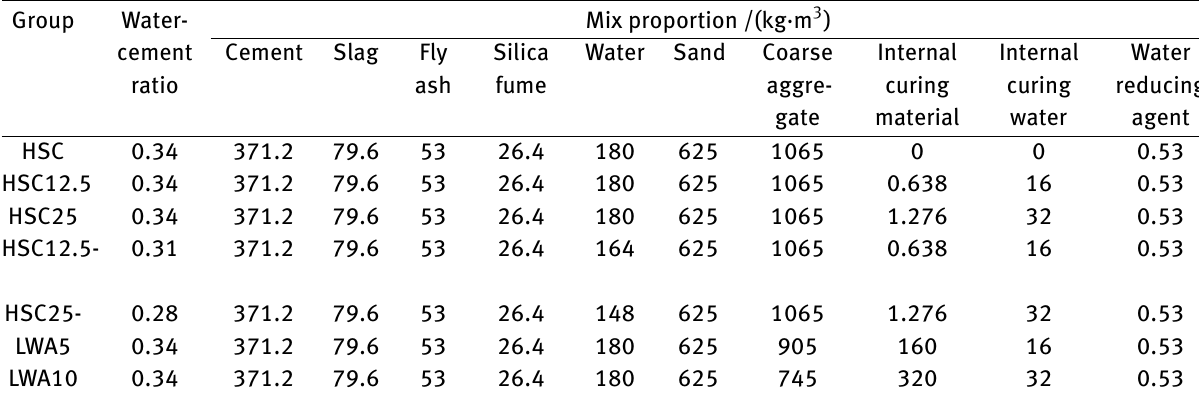
Table 1: Mix proportion of concrete Group Water-